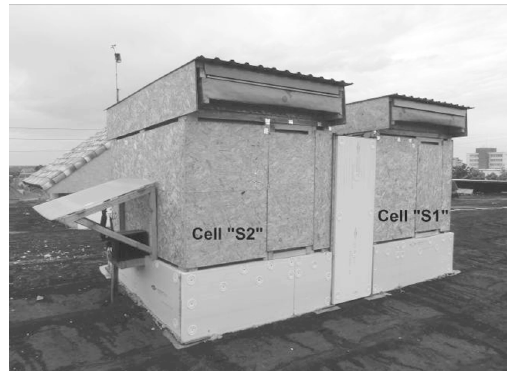
Fig. 1. Experimental cells S1 and S2